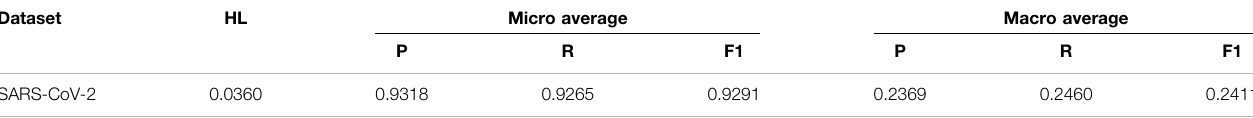
TABLE 7 | Prediction performance of AbCPE server on SARS-CoV-2 data.